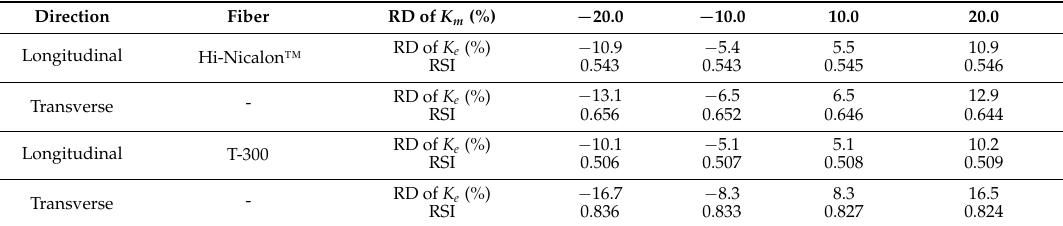
Table 12. Sensitivity analysis of thermal conductivity of matrix for 2D